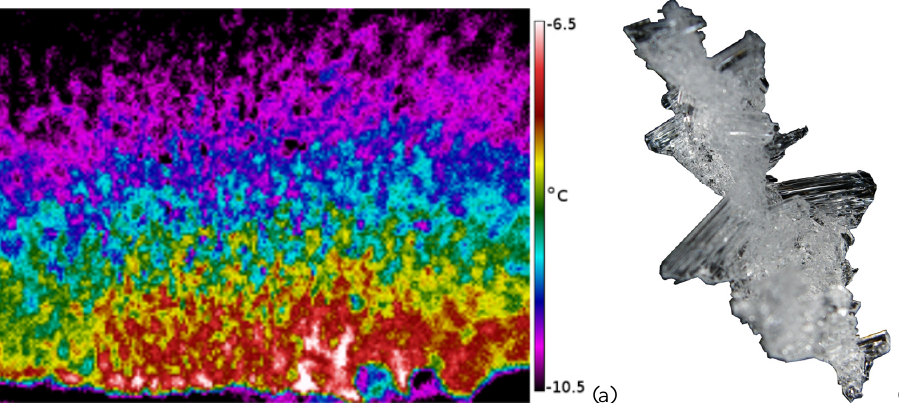
Fig. 9. Thermal application in crystal metamorphosis. (a) An apparent phenomenon of thermal chaining , where chains of mature faceted crystals form aligned from the ground (bottom of image) to the snow surface (top of image). These crystals display physical connection and subsequent isothermal tendencies. They appear as isothermal fingers pointing from the base upwards. The image spans ∼ 30cm in width. (b) A physical depth hoar chain extracted from a similar layer, length ∼